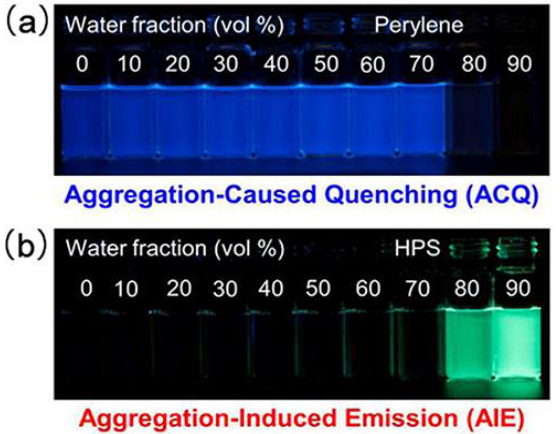
Figure 17. Fluorescence photographs of solutions/suspensions of ( a ) ACQ effect of perylene (20 μmol/L) and ( b ) AIE effect hexaphenylsilole (20 μmol/L) in THF-water mixtures with increasing water contents fraction. Adapted with permission from reference [134]. Copyright 2015, American Chemical Society.